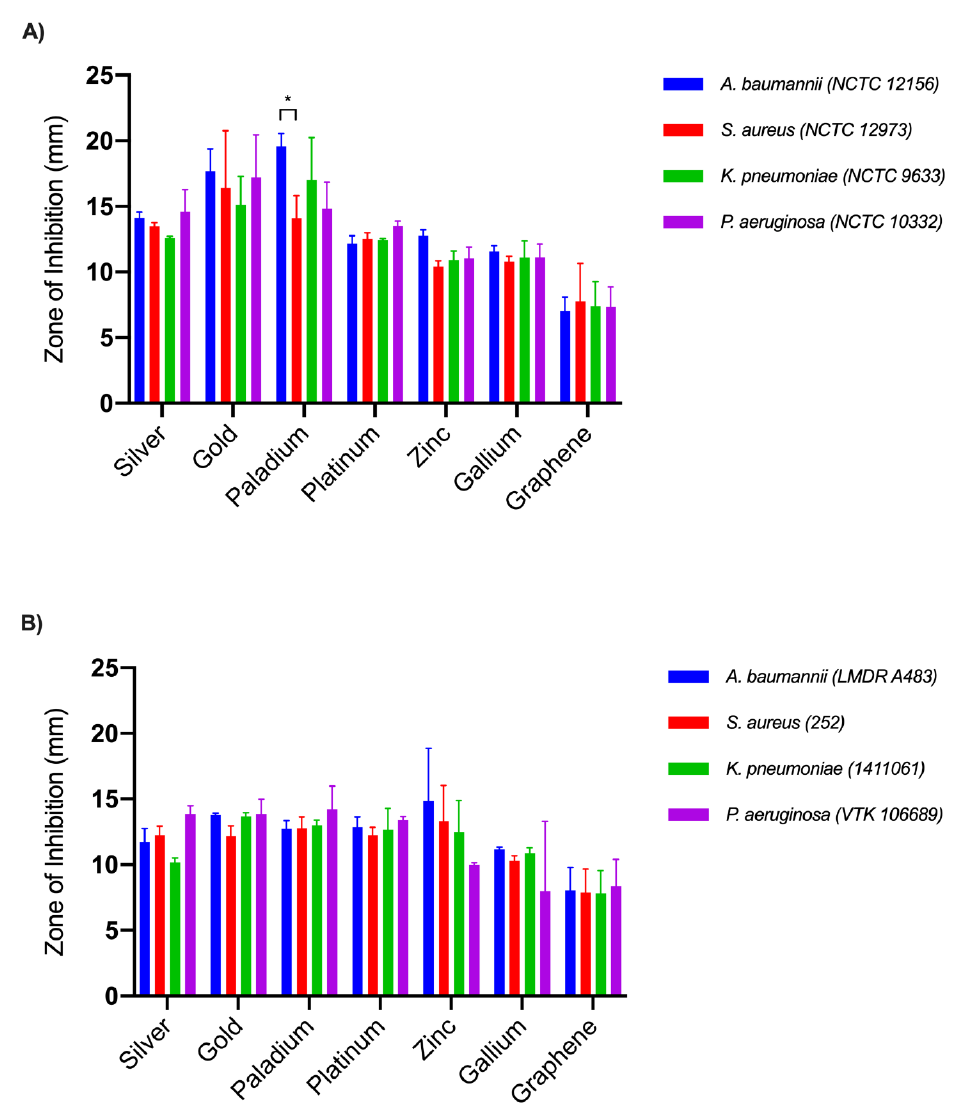
Figure 3. Zone of Inhibition determined by the metal ions and graphene alone against a range of ( A ) susceptible and ( B ) resistant bacteria ( n = 3) * p ≤ 0.05.